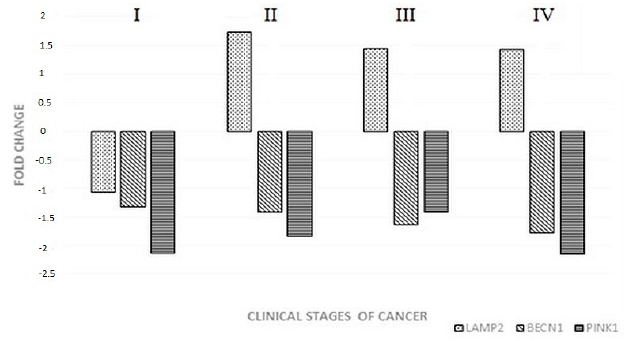
Figure 1. Changes in the expression of LAMP2 , BECN1 , and PINK1 by clinical stage (I-IV) of colorectal cancer.